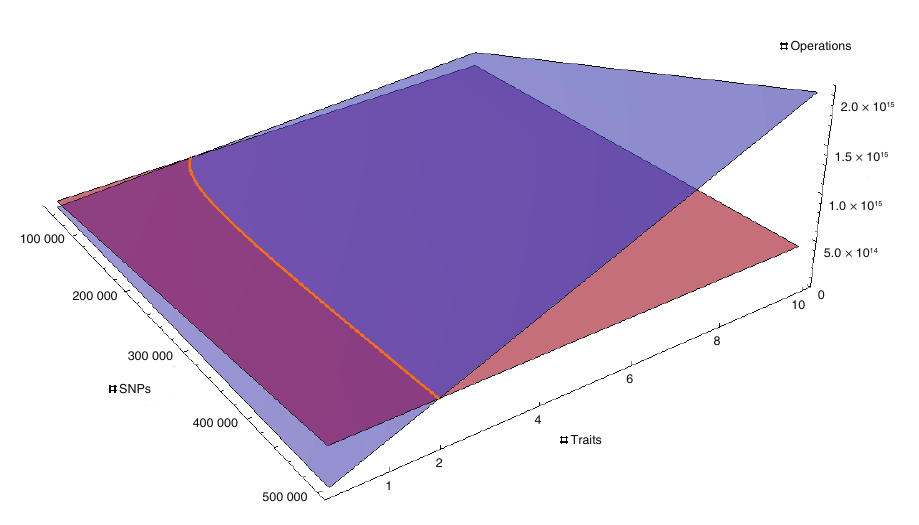
Figure 2. Cost analysis for CLAK-E ig and CLAK-C hol . The brown and blue surfaces indicate the number of operations performed by CLAK-E ig and CLAK-C hol , respectively, for a given number of SNPs and traits. The crossover curve suggests that for analyses with more than just a handful of traits, CLAK-E ig is the fastest